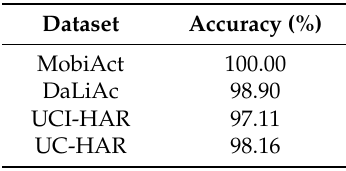
Figure 4. The confusion matrices of the recognition results of our proposed Iss2Image and UCNet6 method on the different datasets: ( a ) MobiAct, ( b ) DaLiAc, ( c ) UCI-HAR, and ( d ) UC-HAR. Table 3. Average recognition accuracy of our proposed method on the different datasets.